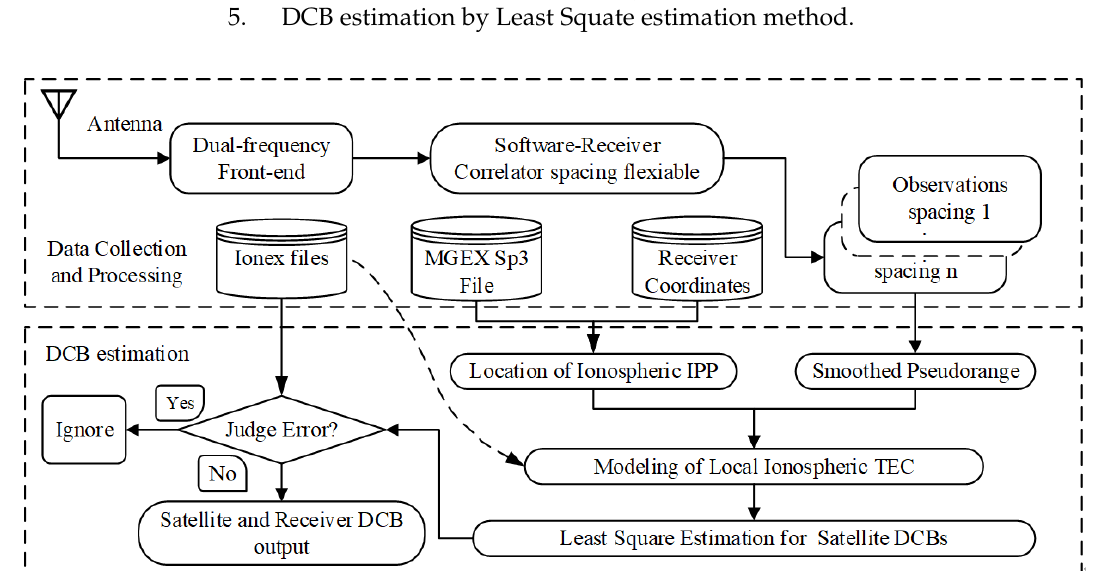
Figure 2. Flowchart of single receiver multi-spacing Differential Code Biases (DCB)